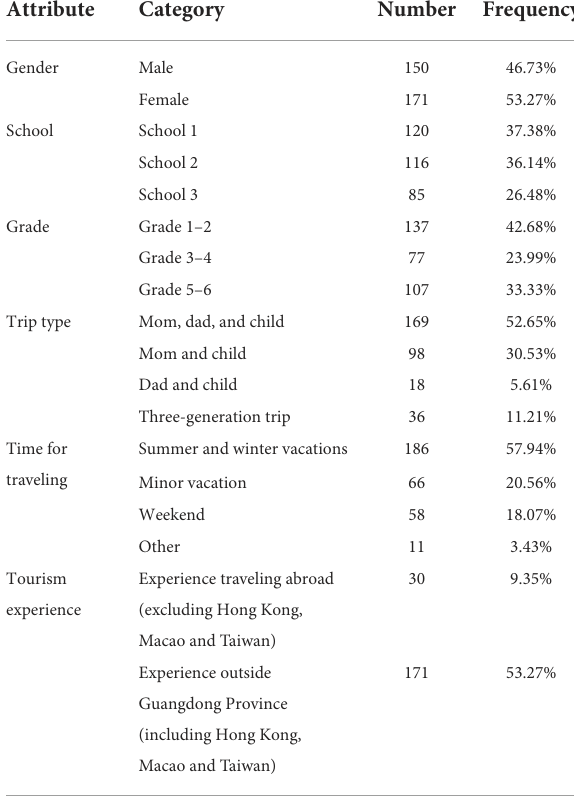
TABLE 2 Descriptive statistical information of valid samples in the survey ( N =